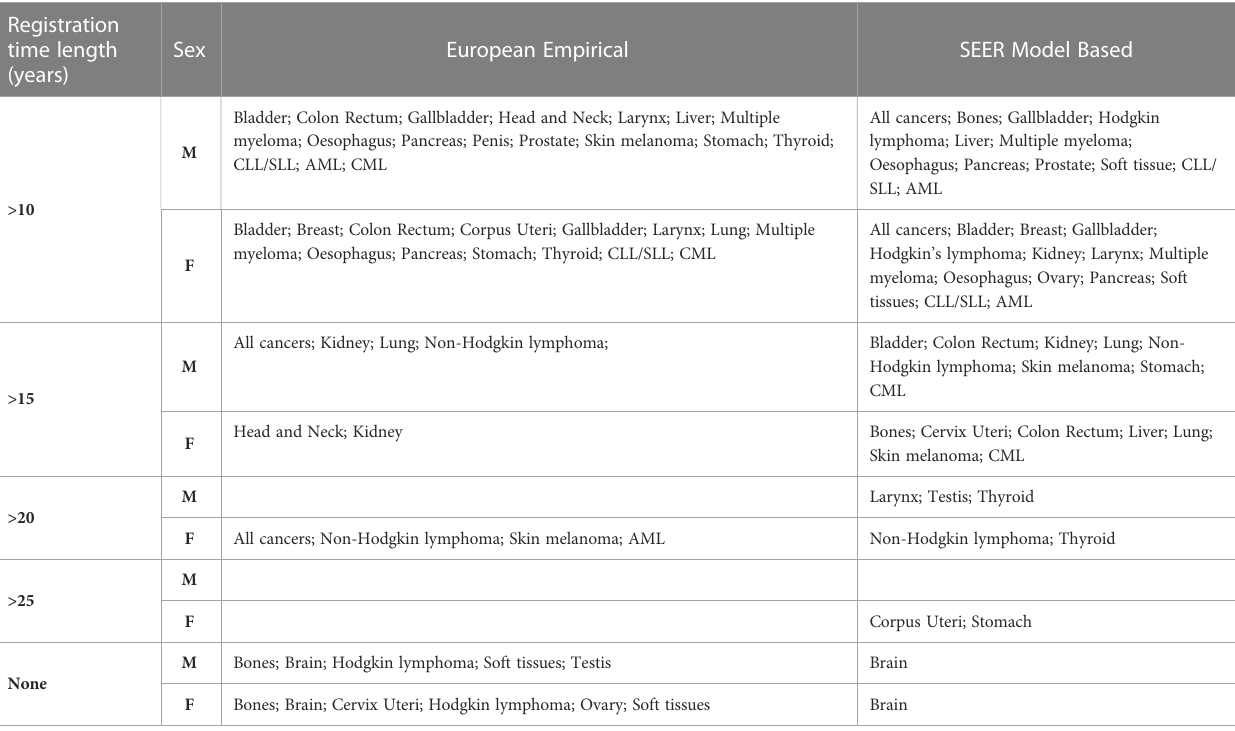
TABLE 5 Summary table reporting the registration time length (years) associated to comparable complete prevalence estimates (within a tolerance lower than 5%) between alternative (Empirical or SEER model-based) and standard completeness index